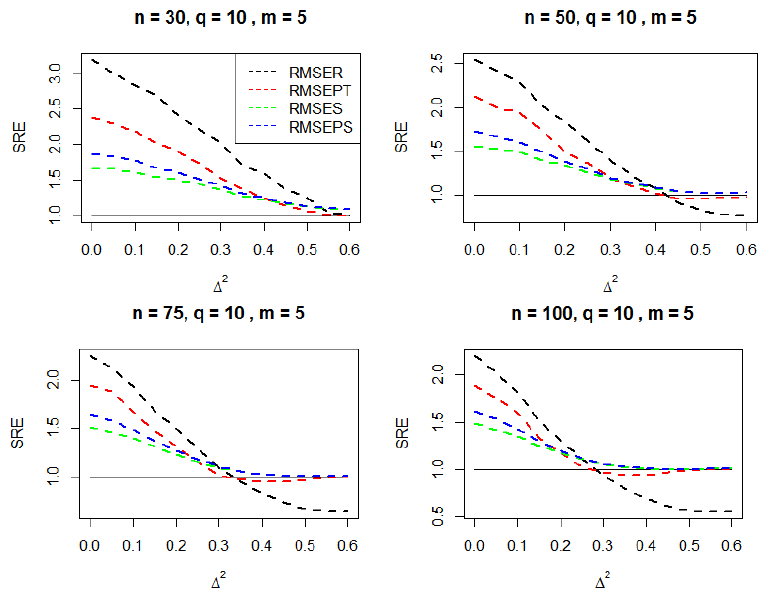
Figure 3. SRE of the restricted, pretest and shrinkage estimators with respect to ˆ θ U when ( m , q ) = ( 5,10 ) and for different sample sizes.